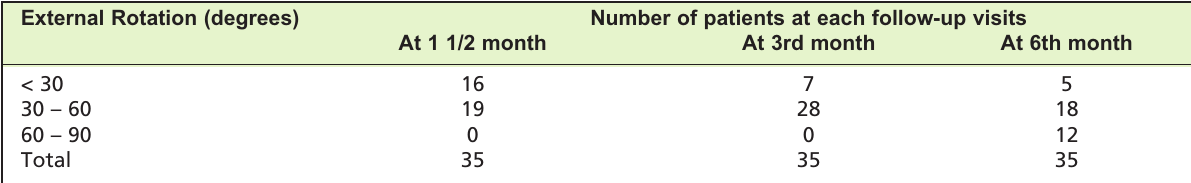
Number of patients in defined external rotation range at each follow-up visit Table III: